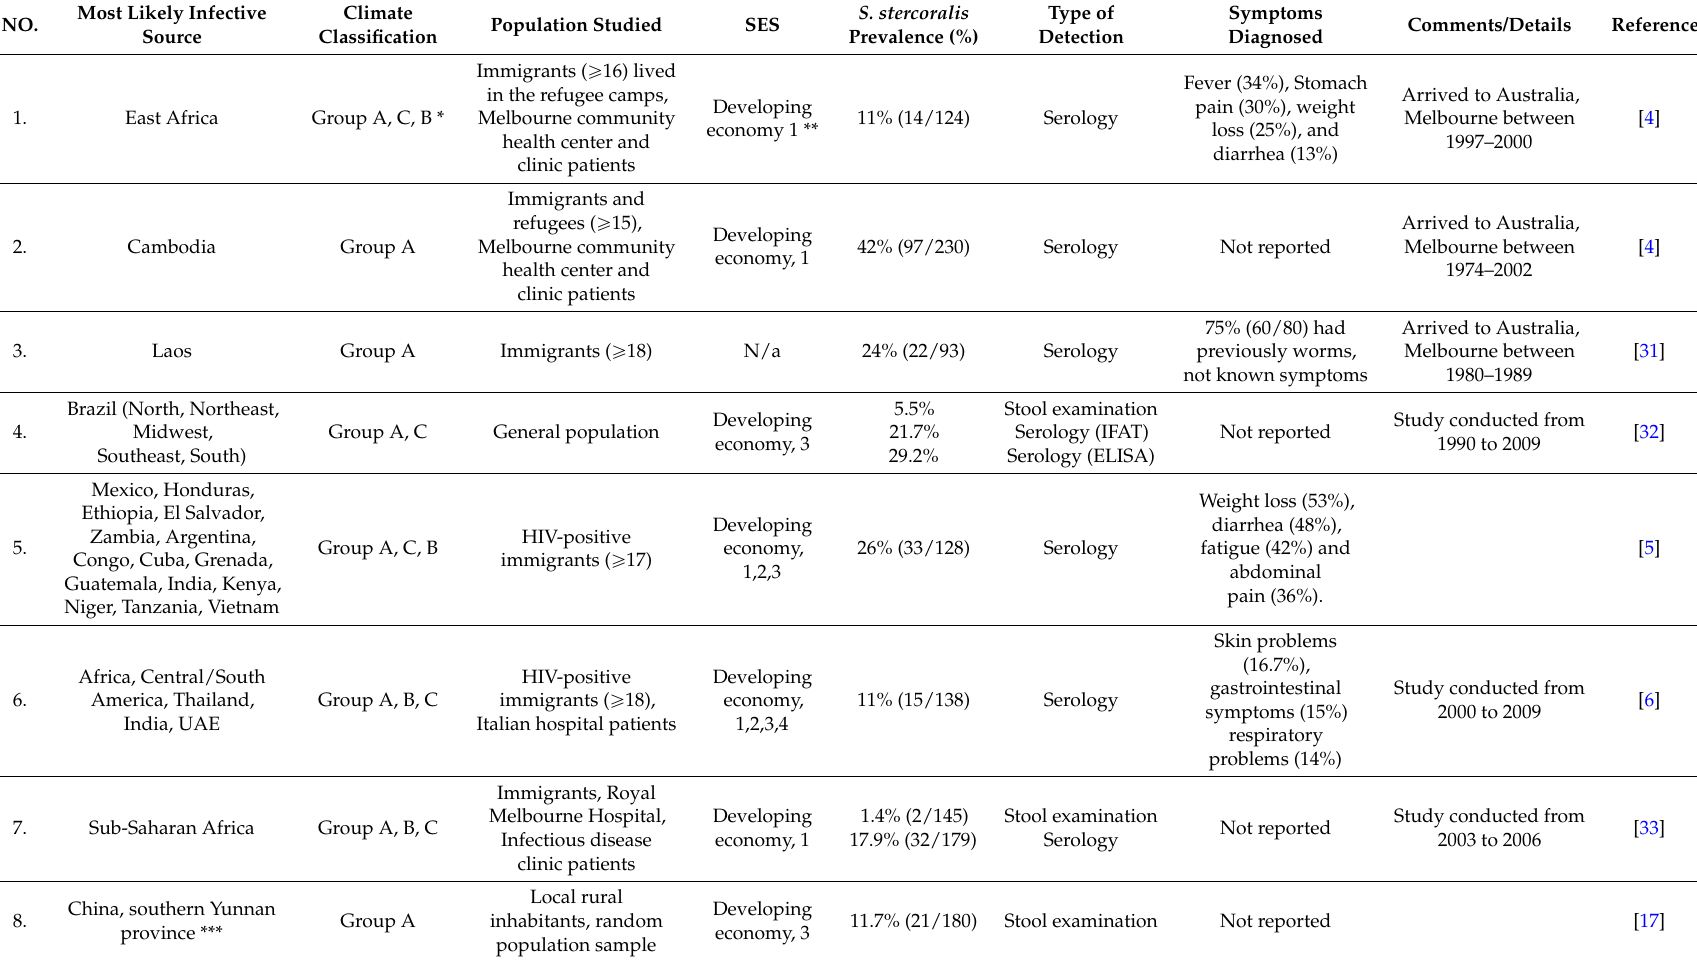
Table 1. Global Strongyloides stercoralis prevalence